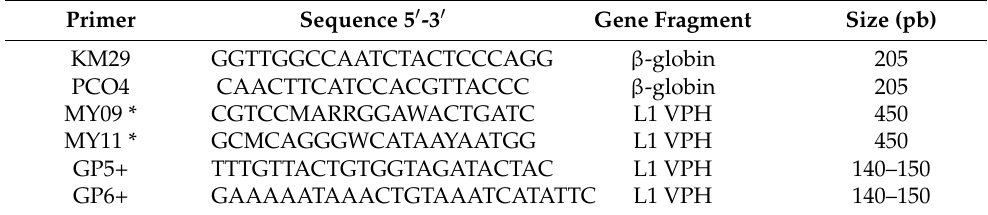
Table 2. Primers used to amplify ß globin fragment and L1 VPH